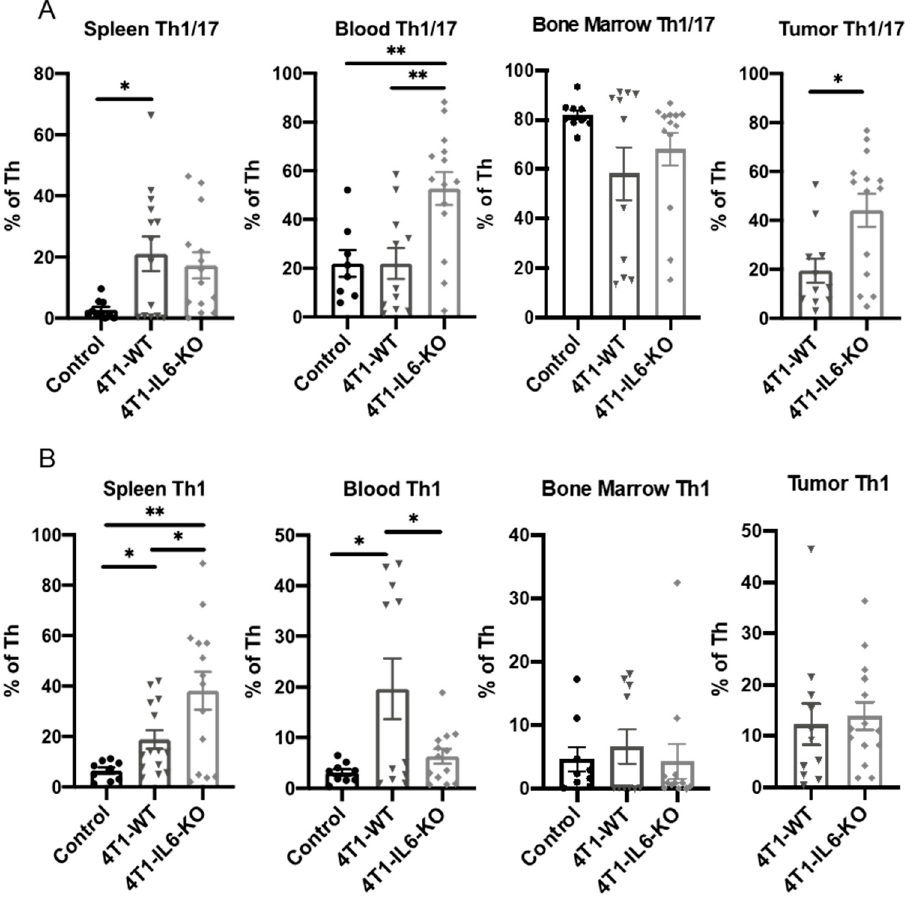
Figure 11. Depleting tumor cell IL-6 increases tumor-infiltrating T h 1/17 cells. Tumors and peripheral tissues harvested 28 d after engraftment of 4T1-WT and 4T1-IL6-KO cell lines were analyzed for proportions of ( A ) T h 1/17 and ( B ) T h 1 subtype T helper cells. Healthy, non-tumor-bearing mice were analyzed for comparison (control); see Figure 2 for gating strategy. Data are presented as mean ± SEM; n = 4–11 mice/group. * p < 0.05, ** p < 0.01.